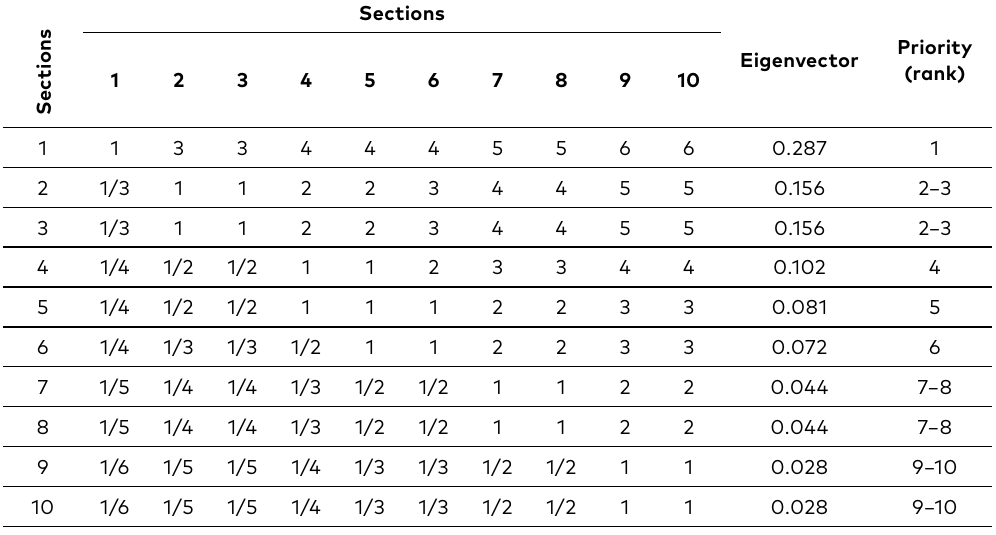
Table 11. Pairwise comparison of the accident